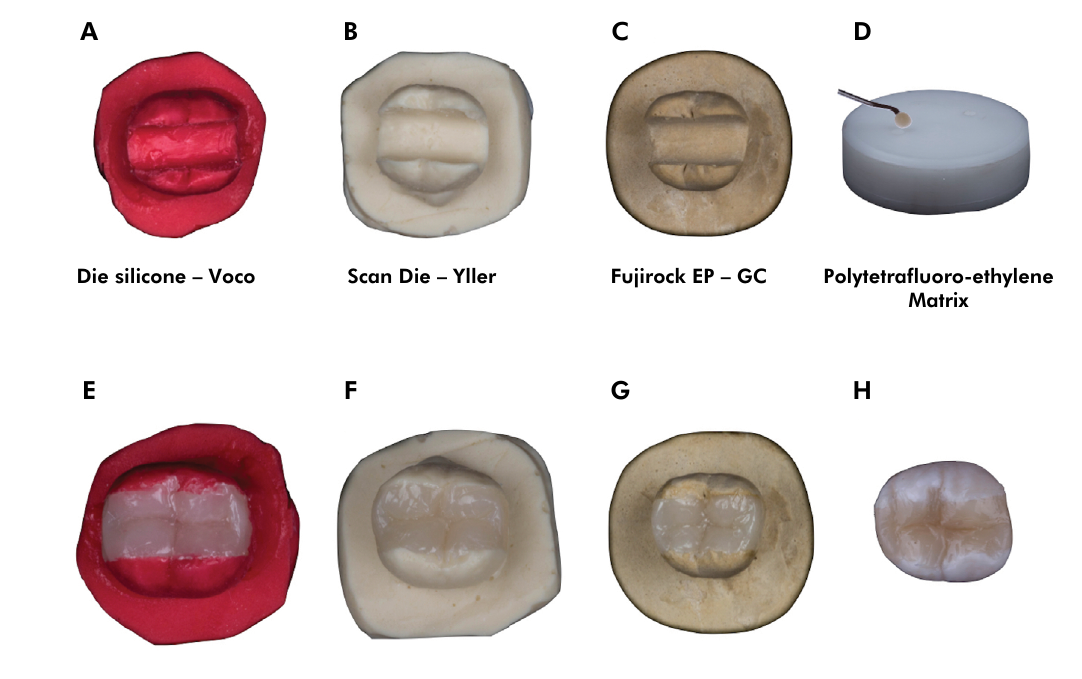
Figure 2. Cast models, polytetrafluoroethylene matrix, and models with restorations. (A) Die silicone – VOCO. (B) Scan die – Yller. (C) Fujirock EP – GC. (D) polytetrafluoroethylene matrix. (E) ICCR-DS. (F) ICCR-SD. (G) IRCR-FR. (H)